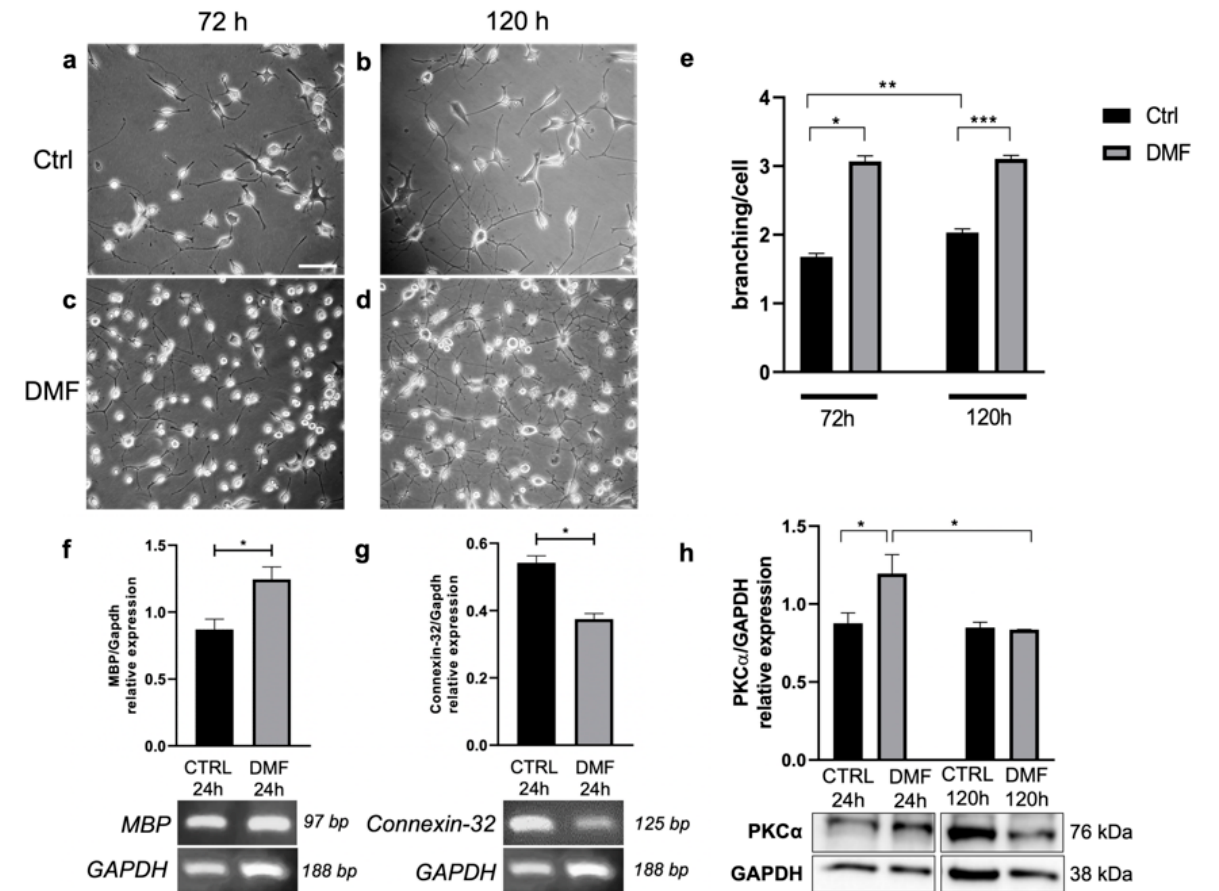
Figure 4. Representative images of Oli neu cells after 72 h or 120 h in the control condition ( a , b ) or after 25 µ M DMF treatment ( c , d ) . Scale bar: 40 µ m. ( e ) In the graph are reported the number of branchings/cells in different experimental conditions at 72 h and 120 h of treatment. Number of cells analysed at 72 h = 205 (in Ctrl DMSO condition) and 200 (in DMF condition); number of cells analysed at 120 h = 590 (in Ctrl DMSO condition) and 639 (in DMF condition). Student’s t -test was used to statistically compare Ctrl and DMF treated cells at 72 h of treatment (* p < 0.05; ** p < 0.01; *** p < 0.001). ( f ) RT-PCR analysis of MBP and ( g ) Connexin-32 transcript levels in Oli neu cells in Ctrl (DMSO) or upon 24 h of 25 µ M DMF treatment. GAPDH was used as housekeeping gene. The gel figures are representative of three independent experiments. Densitometric analysis was obtained from the average ± SEM of three independent experiments. Student’s t -test was used to statistically compare the different experimental conditions (* p < 0.05). ( h ) Western blot analysis of PKC α expression in Oli neu cells in Ctrl (DMSO) or upon 24 h or 120 h of 25 µ M DMF. GAPDH was used as an internal reference protein. The figures are representative of three independent experiments. Densitometric analysis was obtained from three independent experiments. Student’s t -test was used to statistically compare the different experimental conditions (* p <